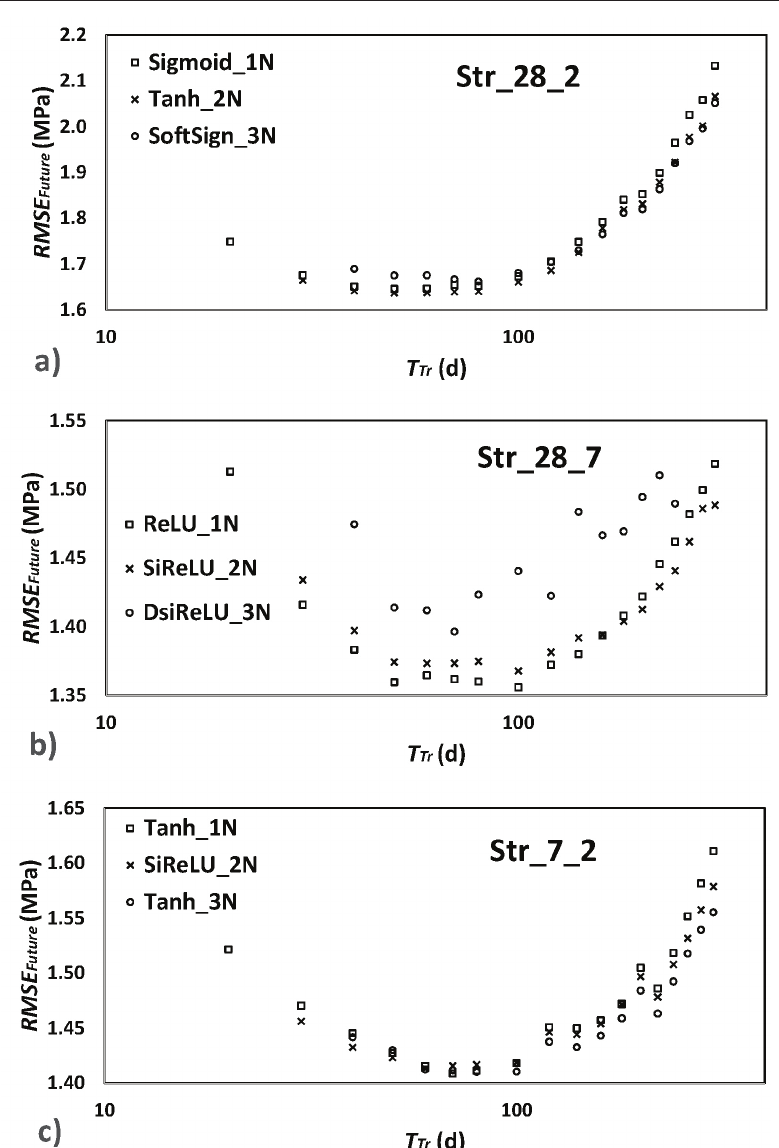
for the models Str_28_2, Str_28_7, and Str_7_2 Future